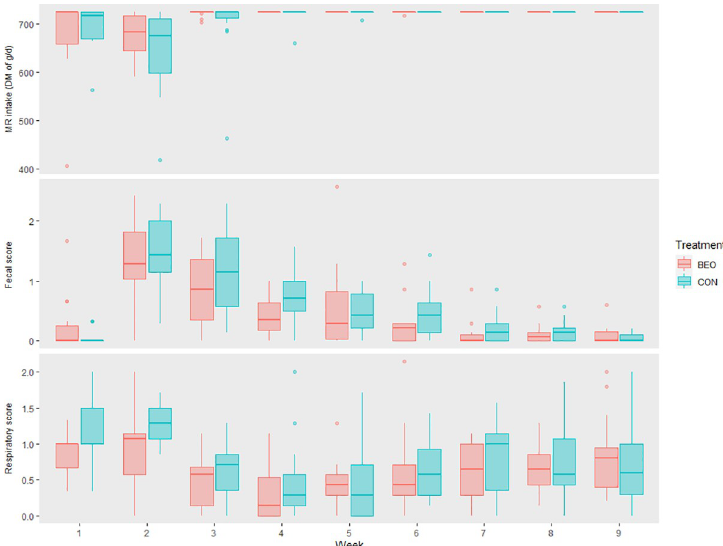
Fig 1. MR intake (g of DM/d), respiratory and fecal scores of control heifers (CON) and heifers supplemented with 1.0 g/calf/ d of the blend of essential oils (BEO) in milk replacer during the pre-weaning period.